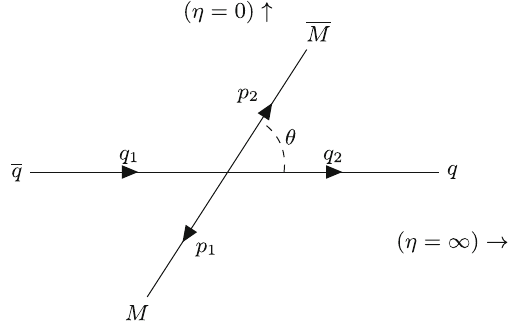
Fig. 28 Definitionofcoordinatespertainingtotheparticle-antiparticle pair production from the interaction of two initial-state particles in the centre-of-mass frame. The process has cylindrical symmetry in the lon- gitudinaldirection( q i ),perpendiculartowhichtheazimuth φ isdefined. The scattering angle θ and pseudorapidity η of the (final-state) M